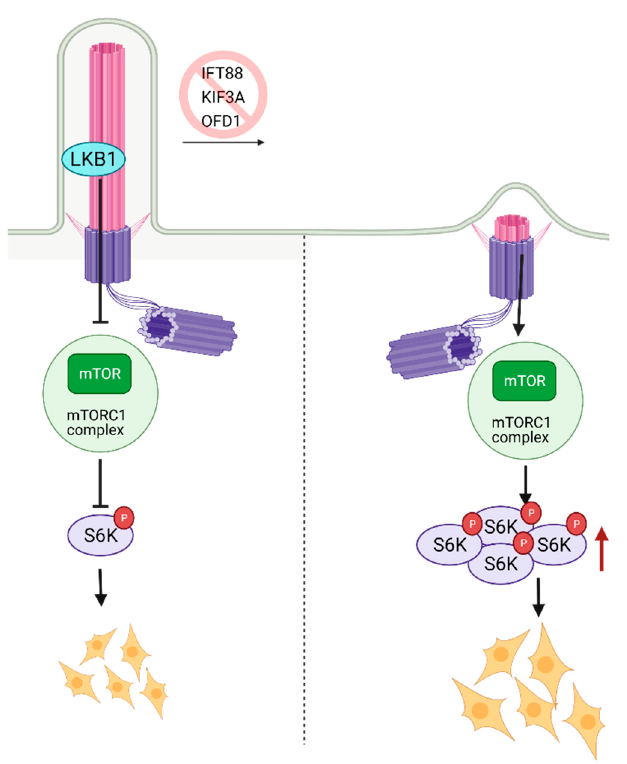
Figure 4. Regulation of mTOR signaling through primary cilia. Ciliary localized LKB1 inhibits mTOR, and keeps mTORC1 activity at a lower level. Inhibition of primary cilia formation results in increased mTORC1 activity, increased levels of active S6K, and larger cell size. Created with Bio-